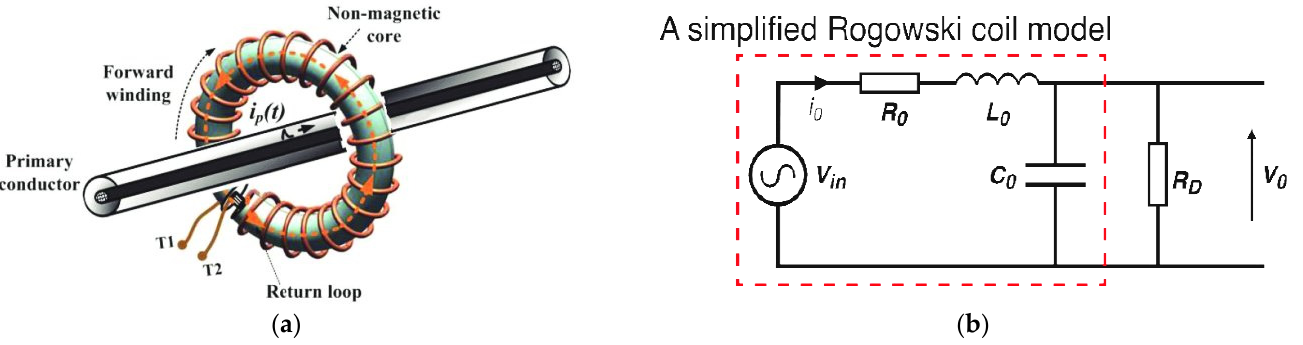
Figure 6. ( a ) principle of the Rogowski coil for measurement of nanosecond ‐ rise time pulsed cur ‐ rent [77], and ( b ) lumped equivalent model of a Rogowski coil